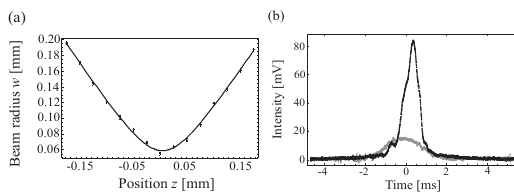
Figure 15. ( a ) Beam radius, w , orthogonal to the direction of propagation as a function of distance ( z ) from a 20 cm focal length plano-convex lens. The beam size was measured using a scanning knife edge beam profiler. The position z = 0 represents the focal spot. The solid line is a fit to ] 1/2 , where z = π w 2 the equation w = w 0 [ 1 + ( z − z 1 ) 2 / z 2 / λ . Here, w 0 is the minimum beam radius, 0 0 0 z 0 is the Rayleigh range and z 1 is an offset that specifies the location of the minimum beam radius from the origin. The fit gives w 0 = ( 58.7 ± 1.3 ) µ m, z 0 = ( 5.8 ± 0.2 ) cm, and z 1 = ( 4.6 ± 0.8 ) mm. ( b ) Spatial profile of a laser beam before (black) and after (grey) passing through an optical fiber. The profile at the entrance to the fiber was obtained by distorting the beam using a scratched cover slide. The profiles represent the analog outputs of a scanning knife edge spatial profiler.